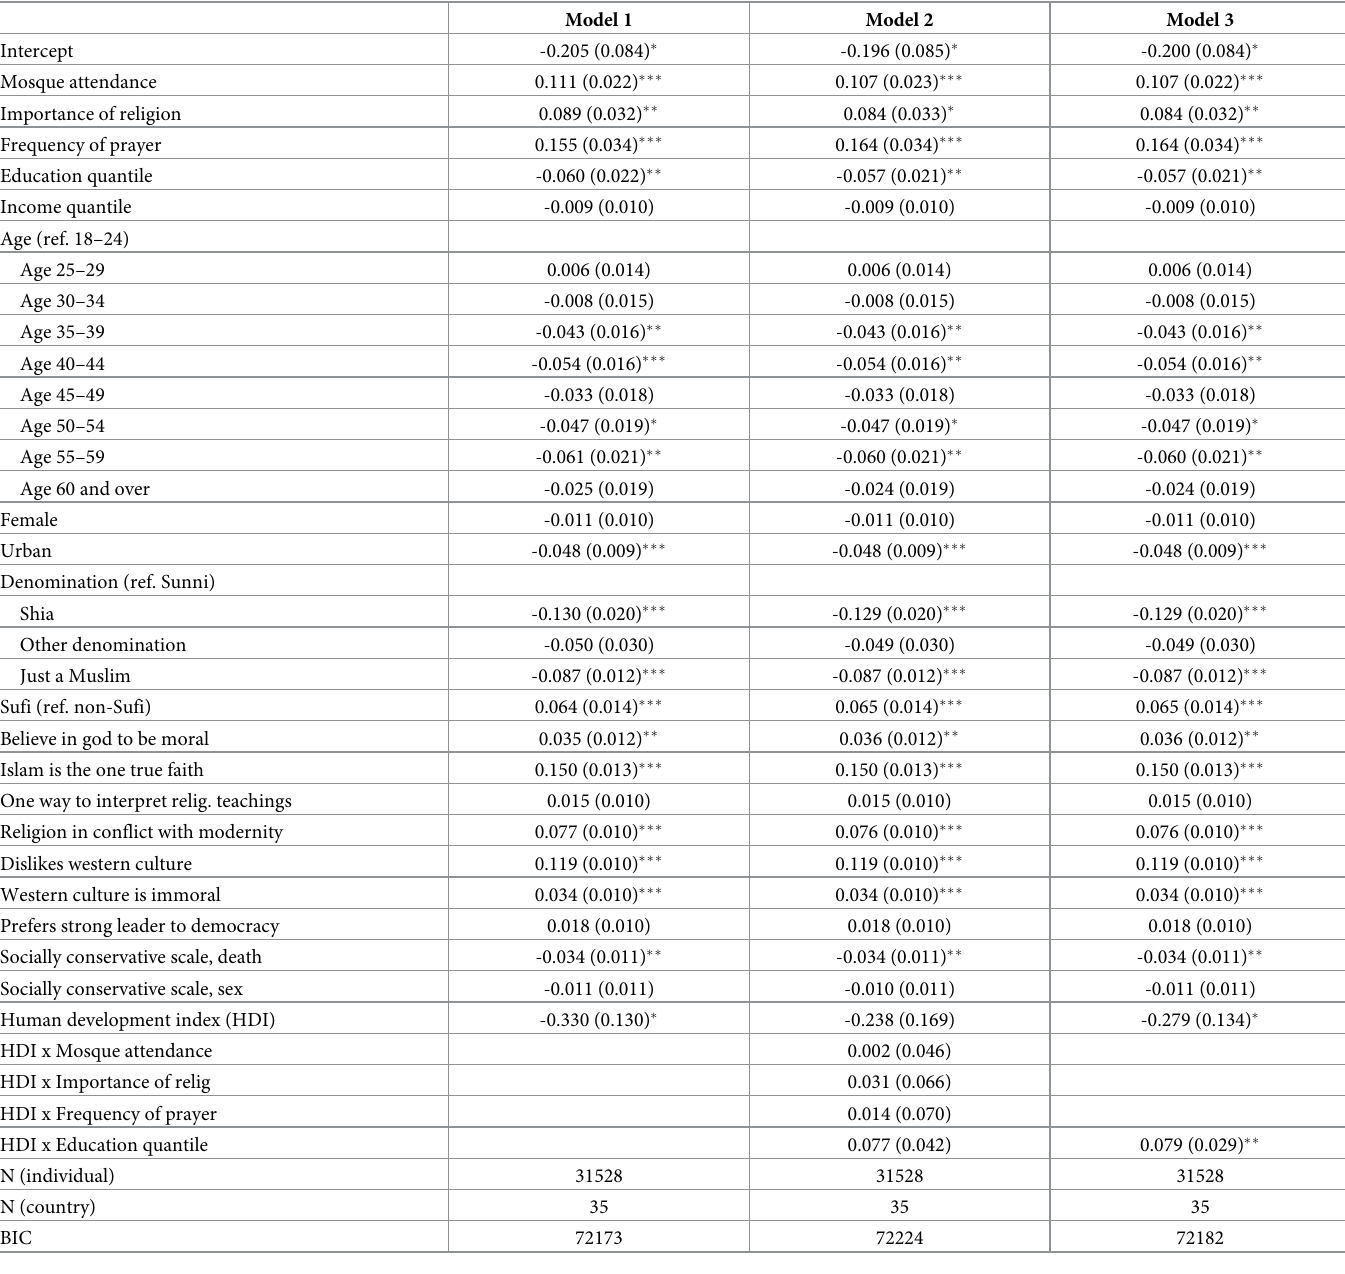
Table 1. Results from multilevel models predicting support for violent practices for violating norms among Muslims.